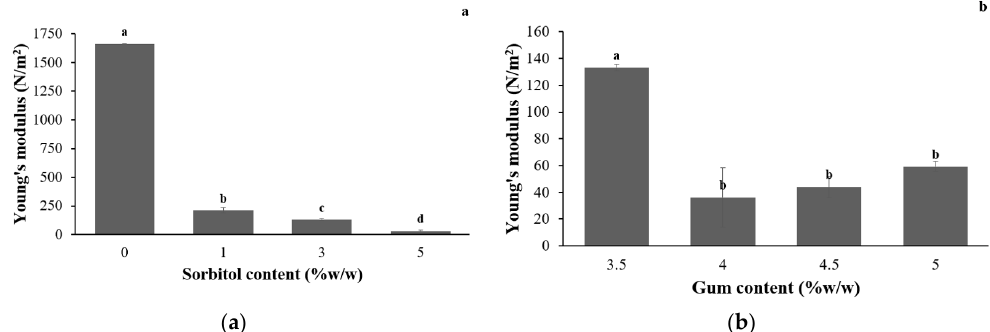
Figure 2. Young’s modulus of gum substrate at different proportions of ( a ) sorbitol (gum fixed at 5%) and ( b ) gum concentration (sorbitol fixed at 3%) (a letter on the bar graph indicates the level of significance; bars denoted by the same letter are not statistically significant ( p >